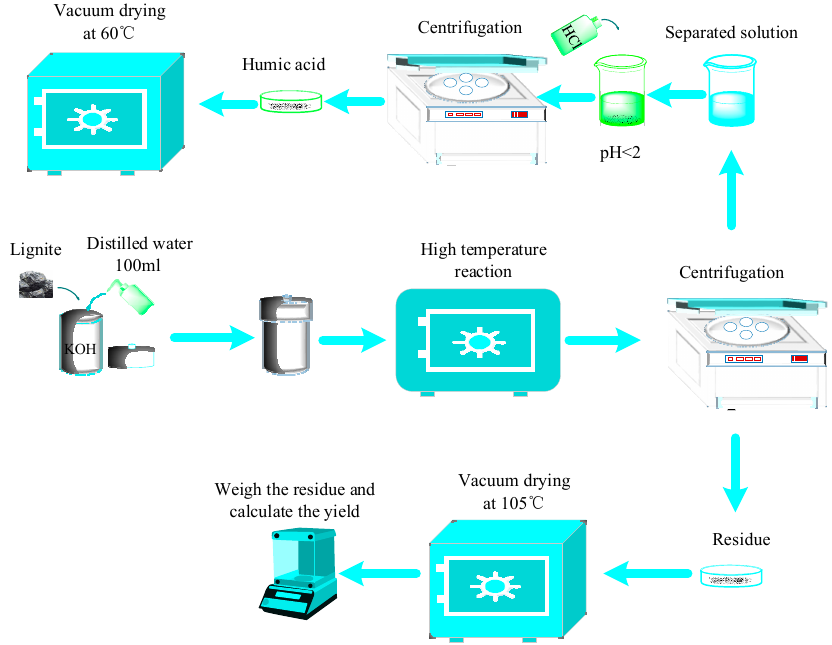
Figure 1. Flow chart of humic acid (HA) extracted by the hydrothermal